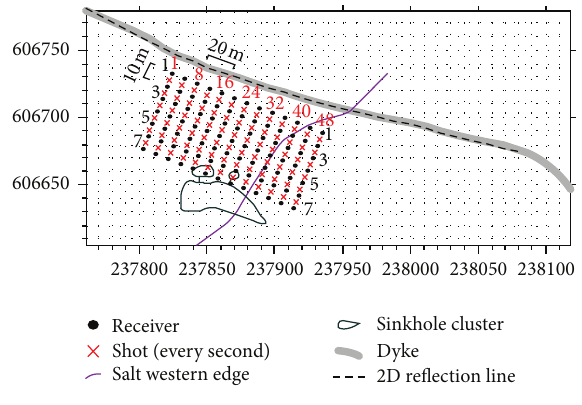
Receiver Shot (every second) Figure 5: The geometry of 3D seismic